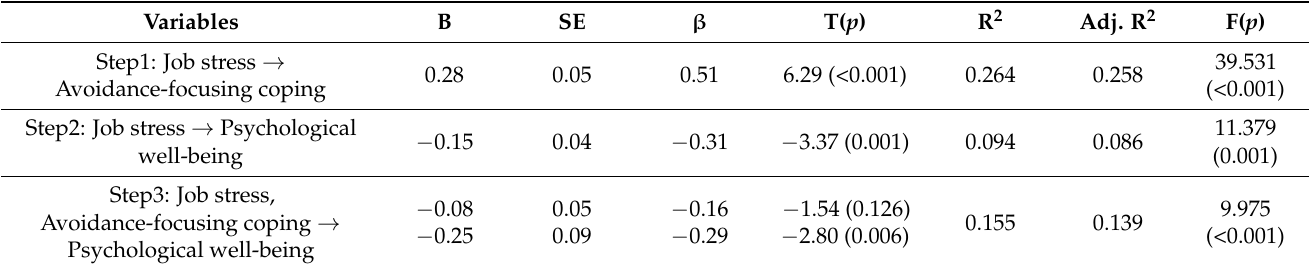
Table 6. Mediating effects of avoidance-focusing coping in the relation between job stress and psychological well-being in